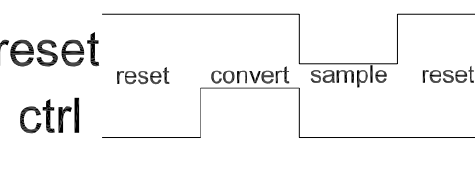
Figure 4. Typical input waveforms for the developed C/V